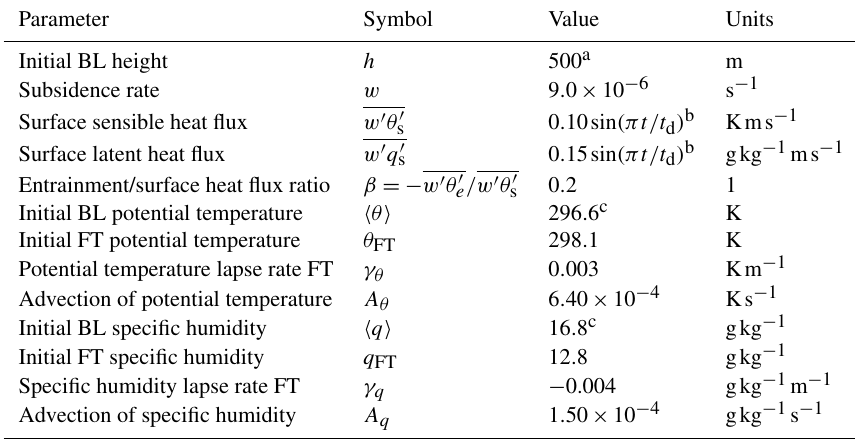
Table 2. The initial and boundary conditions used in MXLCH. Parameter Symbol Value Units Initial BL height Subsidence rate Surface sensible heat flux w (cid:48) θ (cid:48) s Kms − 1 Surface latent heat